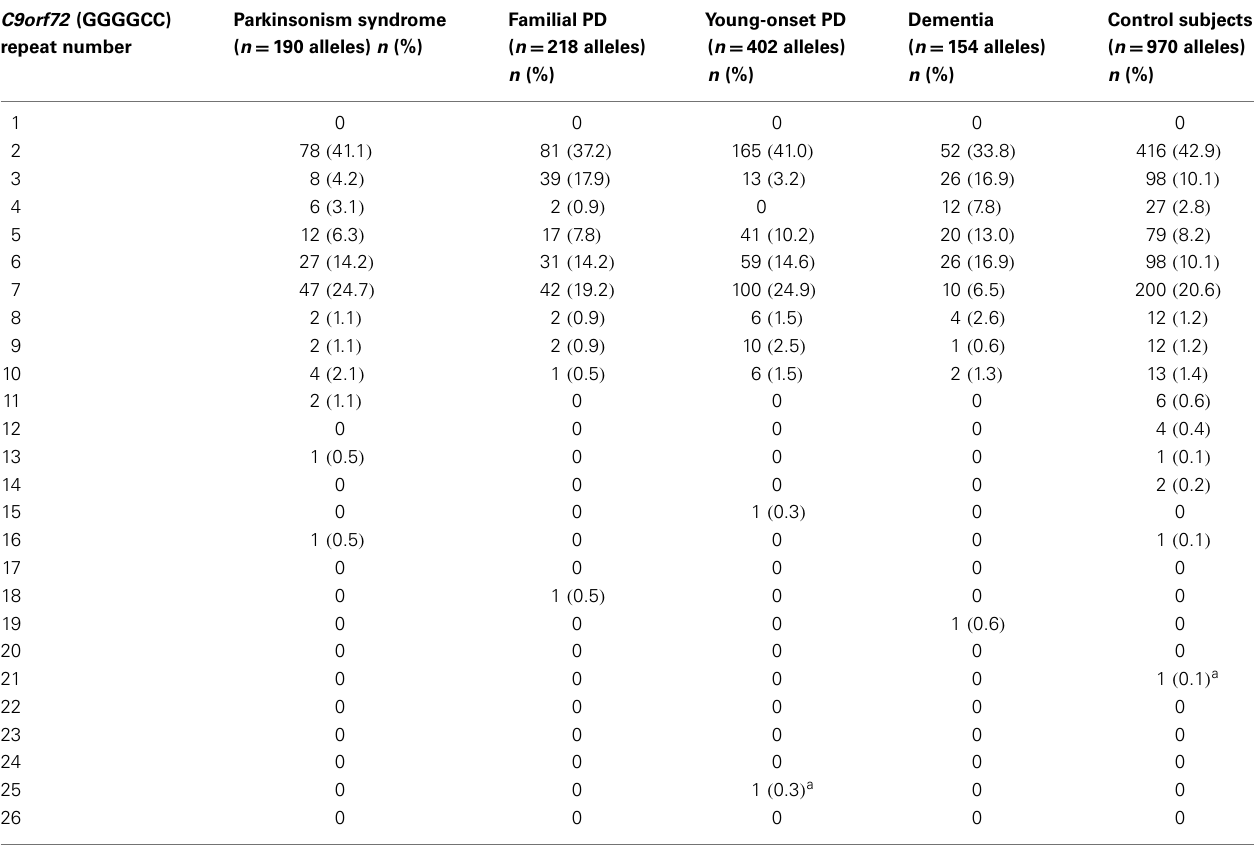
Table 2 | Distribution of C9orf72 (GGGGCC) repeat numbers in each disease group and control subjects